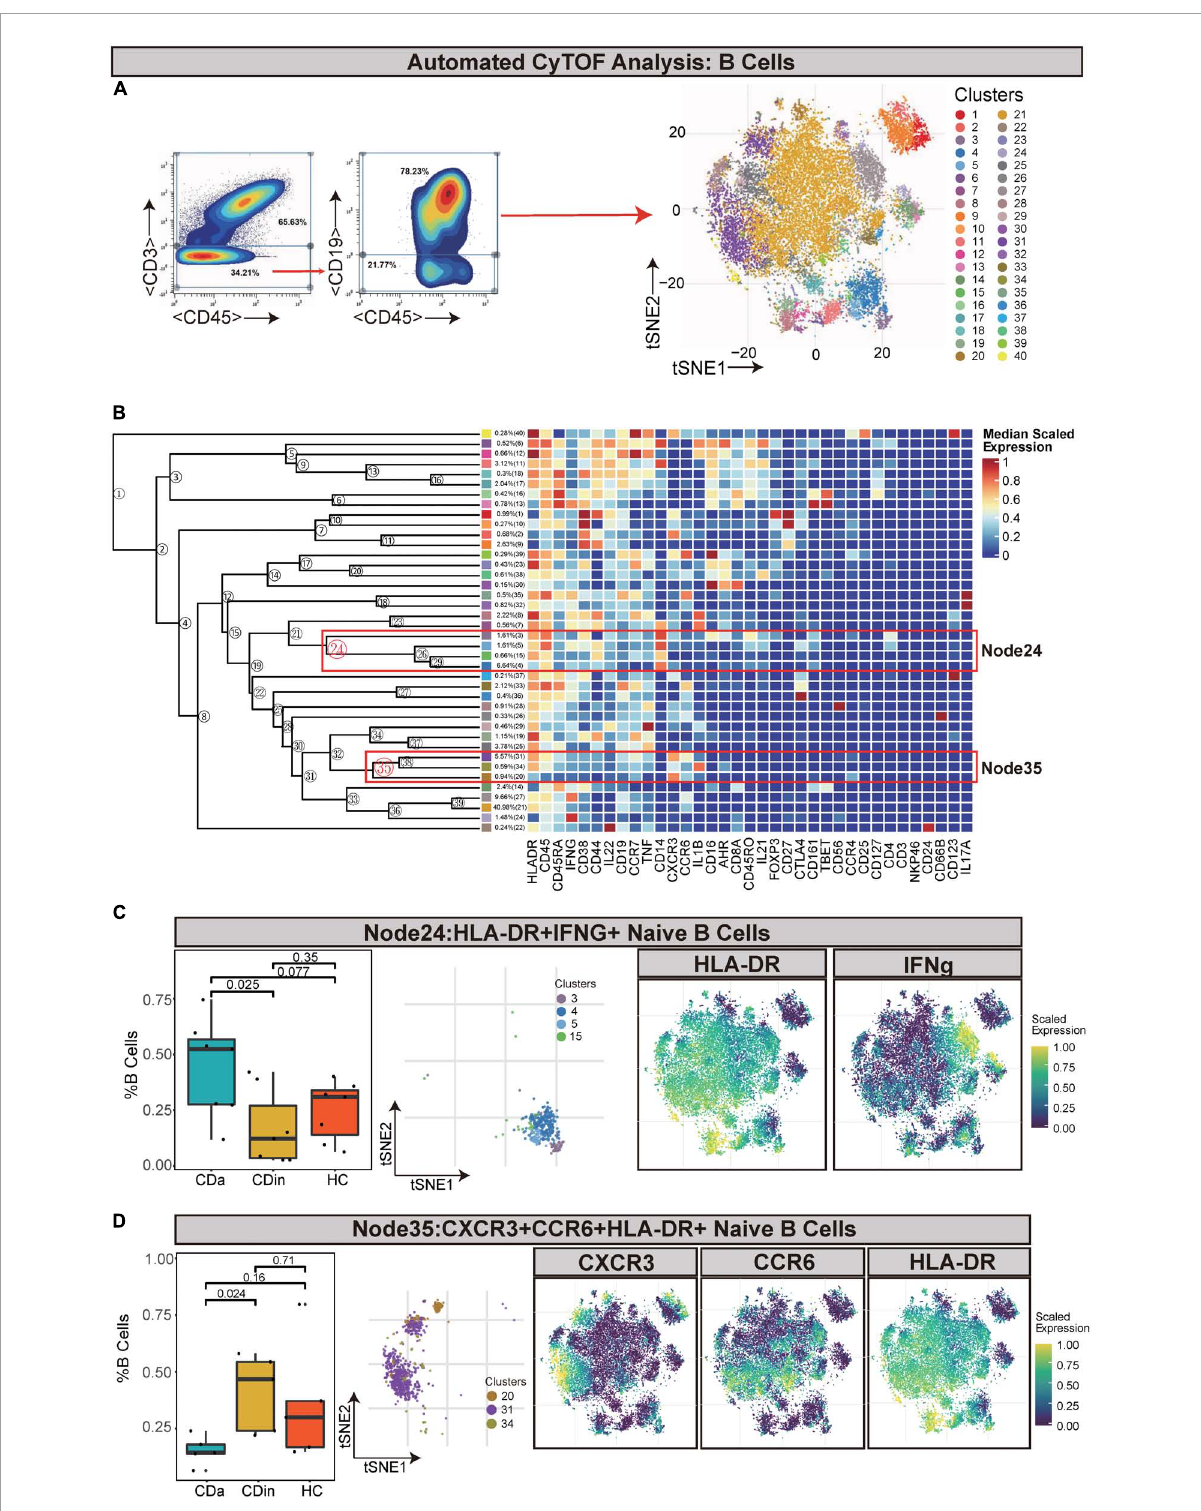
FIGURE4 CyTOF analysis showed differences in naïve B cells among CDa, CDin, and HC. (A) Gating strategy (left) and t-SNE projection (right) of B cells derived from CyTOF data. (B) Cluster dendrogram and heatmap of B cells. (C) The percentage of Node24 in B cells among three groups (left) and the t-SNE plot of Node24 with gene expression feature plot for HLA-DR/IFNg (right). (D) The percentage of Node35 in B cells among three groups (left) and the t-SNE plot of Node35 with gene expression feature plot for CXCR6/CCR6/HLA-DR